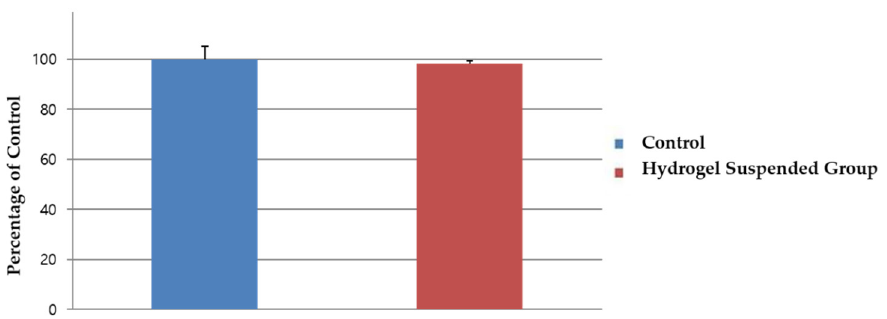
Figure 9. Findings of the cell viability test performed using a cell counting kit (CCK)-8 kit. The cell viability was not affected by the presence of the hydrogel.